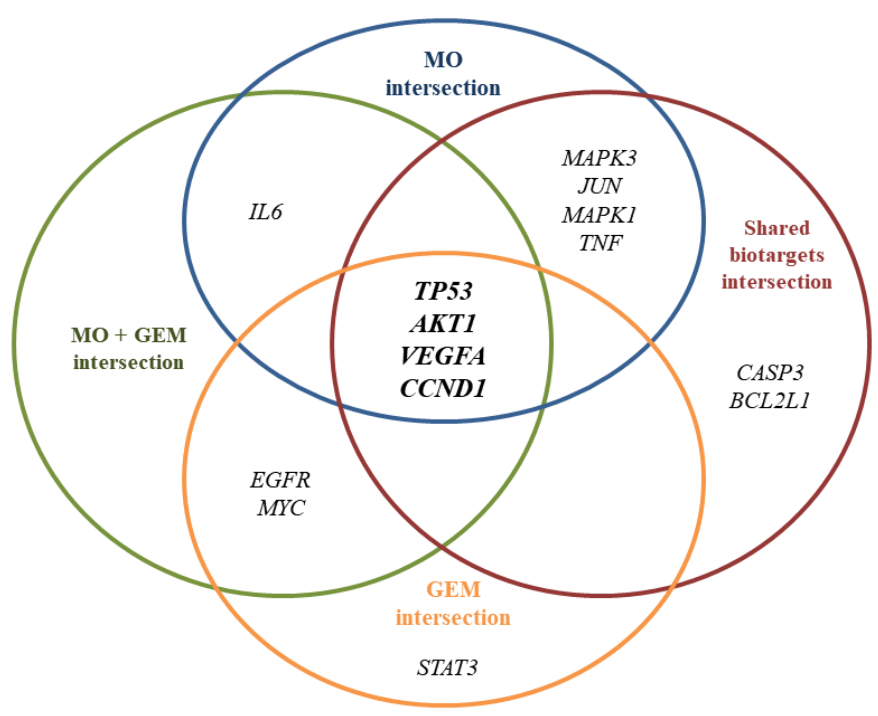
Figure 3. Hub genes derived from the PPI network based on degree, closeness, and betweenness values. TP53 , AKT1 , VEGFA , and CCND1 are the hub genes that overlapped between the 4 intersection networks against pancreatic cancer.